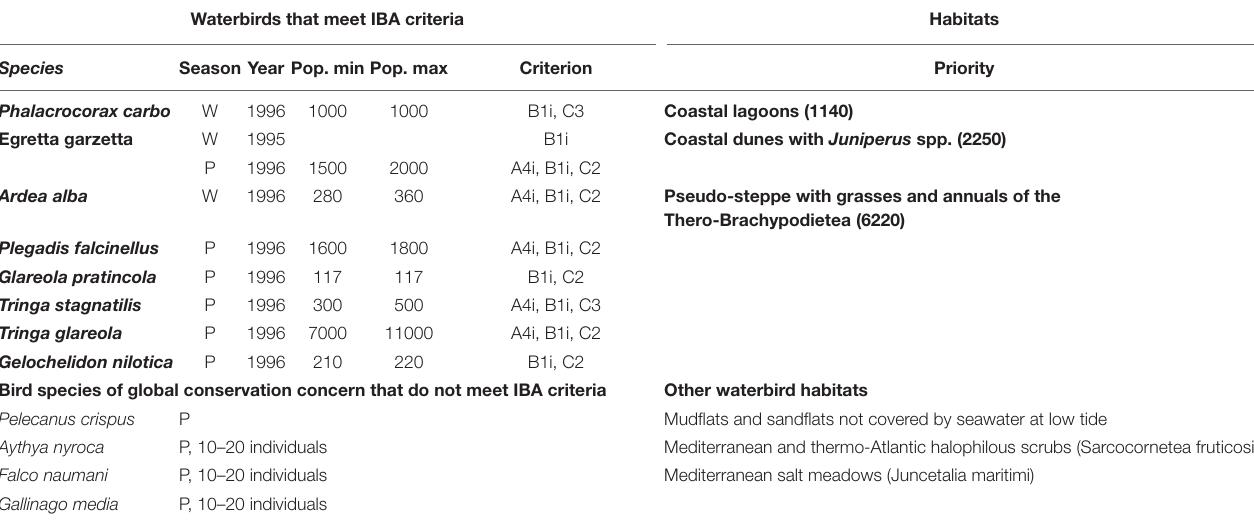
TABLE 1 | Waterbirds in GLw-Natura2000 that meet the IBA criteria A4i, B1i, C2, C3 (Heath et al., 2000; BirdLife International, 2001), and species of global conservation concern that do not meet IBA criteria (Hellenic Ornithological Society [HOS], 2019b). Waterbirds that meet IBA